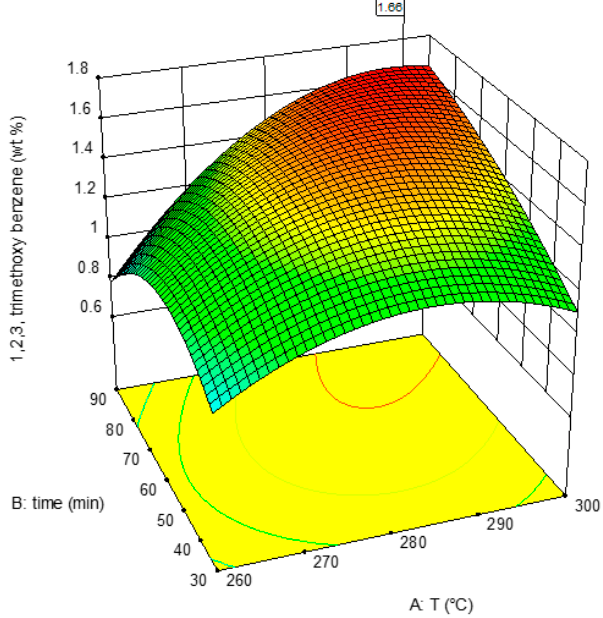
Figure 7. Prediction of the 1,2,3-trimethoxy benzene production at different conditions of temperature and residence time.